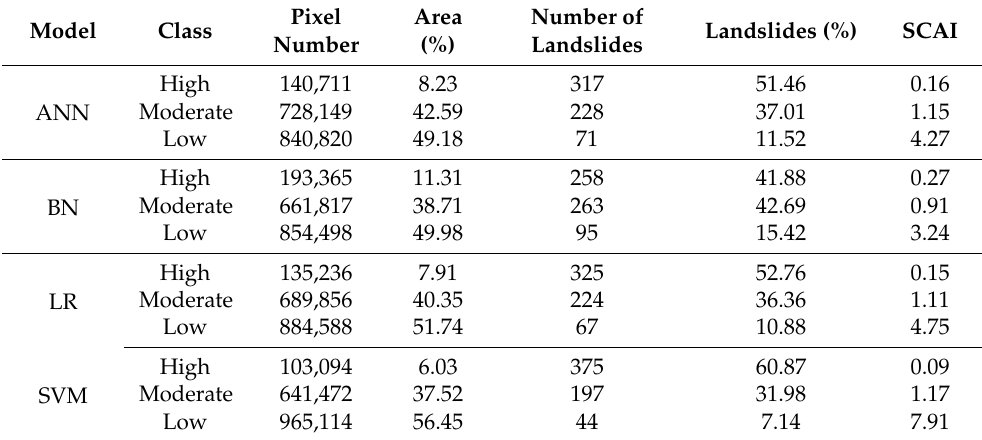
Table 2. The densities of landslide occurrence (SCAI) for ANN, BN, LR, and SVM